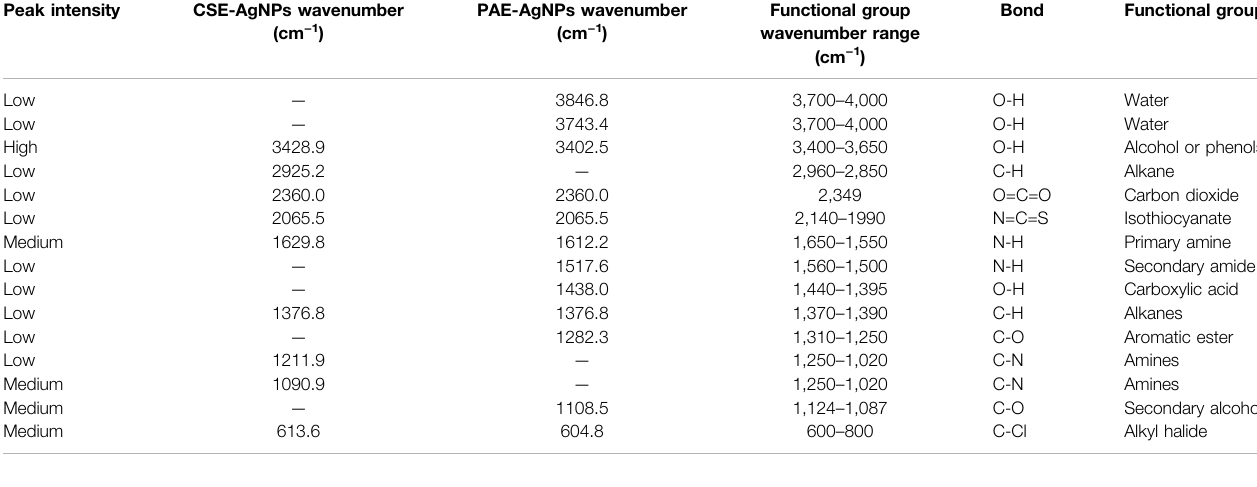
TABLE 3 | AgNPs-CSE – and AgNPs-PAE – associated organic functional groups as revealed by the FTIR analysis. Peak intensity